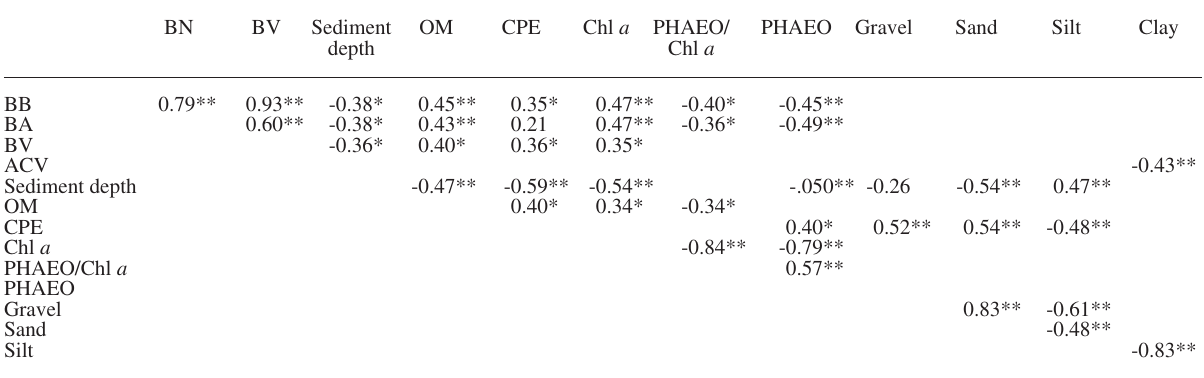
Table 2. – results of correlation analysis between investigated parameters (BB, bacterial biomass; Ba, bacterial abundance; Bv, bac- terial volume; acv, average cell volume; oM, organic matter; cPe, chloroplastic pigment equivalents; chl a , chlorophyll a ; PHaeo, phaeopigments).